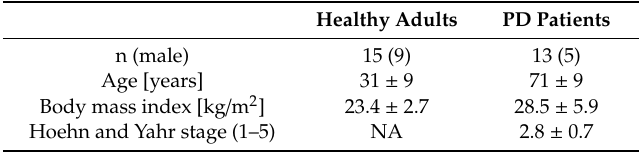
Table 1. Demographics (mean ± standard deviation) of the subjects.